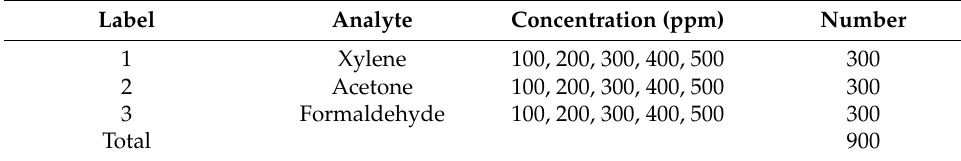
Table 1. The datasets in detail.